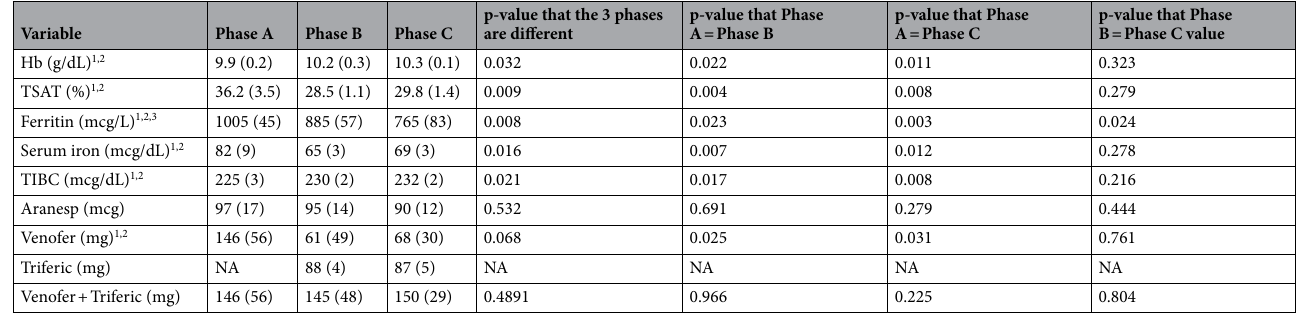
Table 2. Repeated ANOVA analysis at the clinic level. 1 indicates a statistically significant difference between Phase A and Phase B. 2 indicates a statistically significant difference between Phase A and Phase C. 3 indicates a statistically significant difference between Phase B and Phase